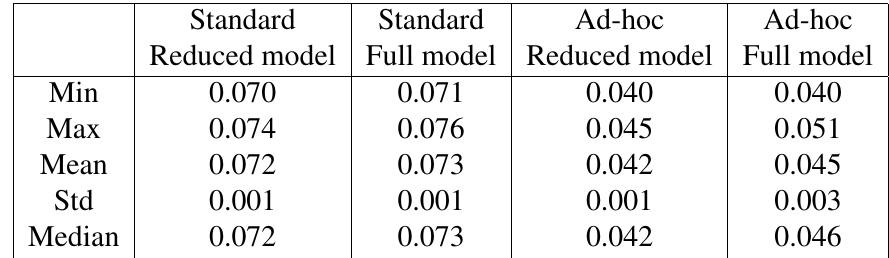
Table 4: RMSE of the experiments run with the Standard and Ad-hoc networks. For each columns. For each column, statistics over 50 runs of the proposed adap- tive procedure are